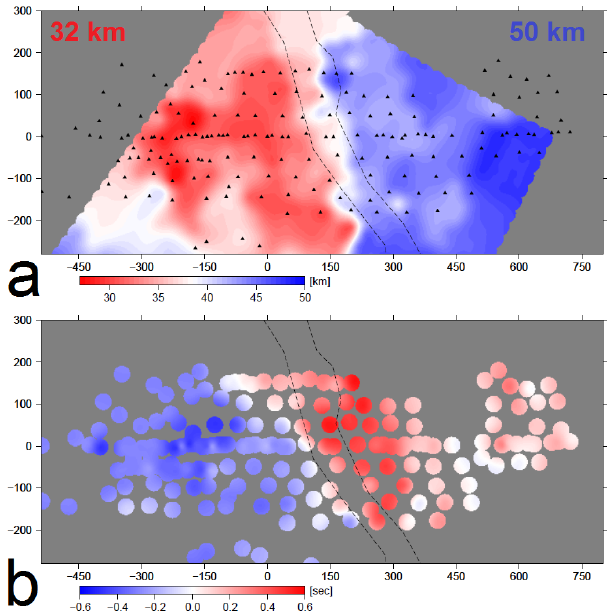
Figure 5. (a) Moho map of the precise 3-D crustal model by Ma- jda´nski (2012), which was used to estimate the crustal TT correc- tions. The Moho depth for the areas outside the model was defined using results of some DSS projects: the area to the east was assigned 50km and, to the west 32km. (b) Estimated crustal TT corrections in the individual seismic stations. The values are expressed in sec- onds with respect to the IASP91 velocity